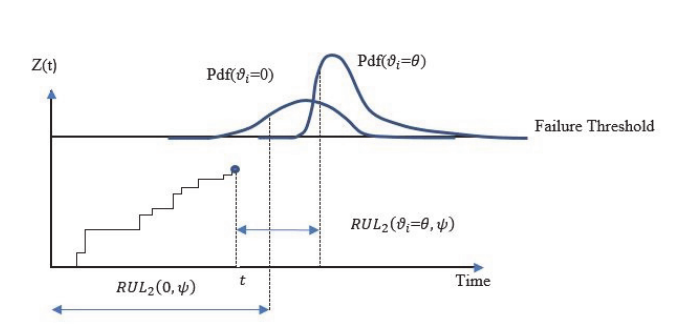
Fig. 3 . The process of updating the remaining life distribution of the shock